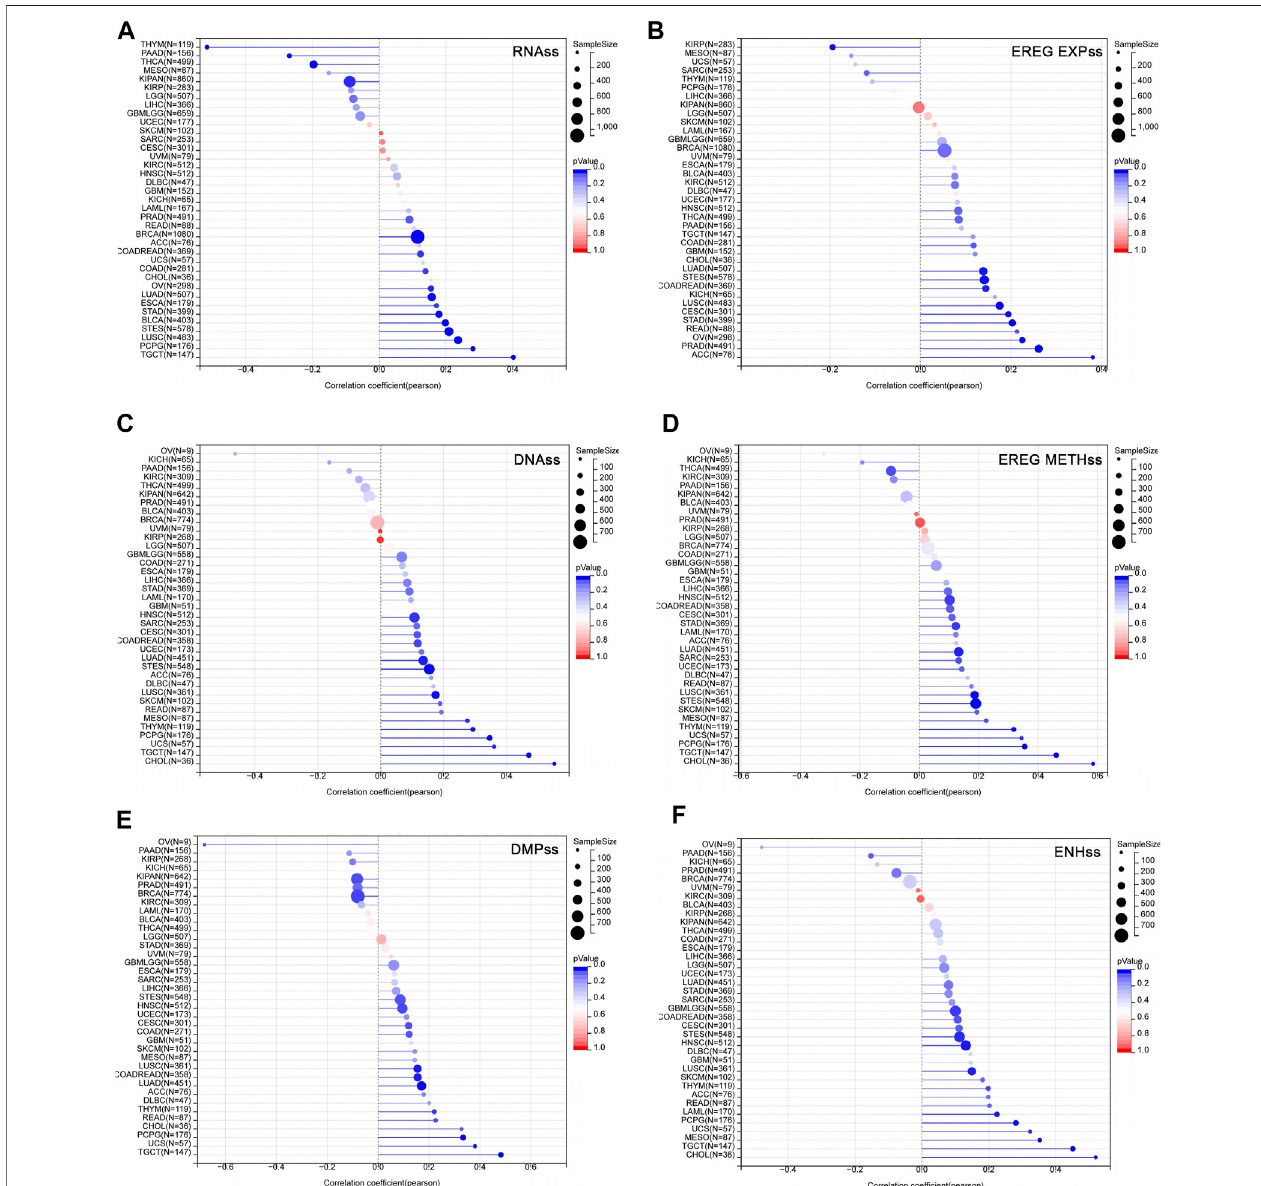
FIGURE 6 | Correlation of USP45 with tumor stemness in different types of tumors. The stemness index included RNAss, EREG EXPss, DNAss, EREG METHss, DMPss, and ENHss based on mRNA expression and DNA methylation. The correlation between USP45 and tumor stemness index, including RNAss (A) , EREG EXPss (B) , DNAss (C) , EREG METHss (D) , DMPss (E) and ENHss (F) were analyzed based on the TCGA